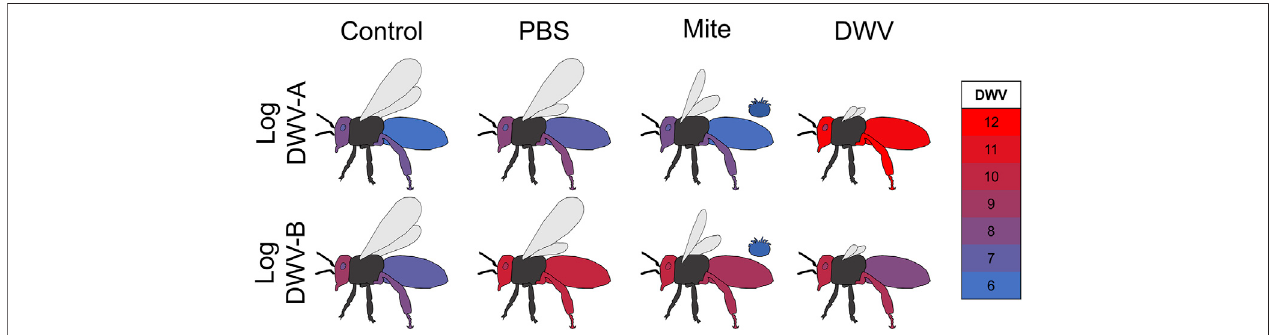
FIGURE3| DWVdisseminationinnewlyemergedadultbees.Meanlog-transformedDWV-AandDWV-Bvalues(colorvaluesscaledforoverallDWVlevels)ineach sampled tissue type (abdomen, head, hypopharyngeal gland, and rear leg) for each treatment (uninjected control, PBS injection, Varroa mite exposure, and DWV injection). Dissemination patterns differed between the two DWV variants but was not related to bee stock (displayed DWV values were averaged across bee stocks).